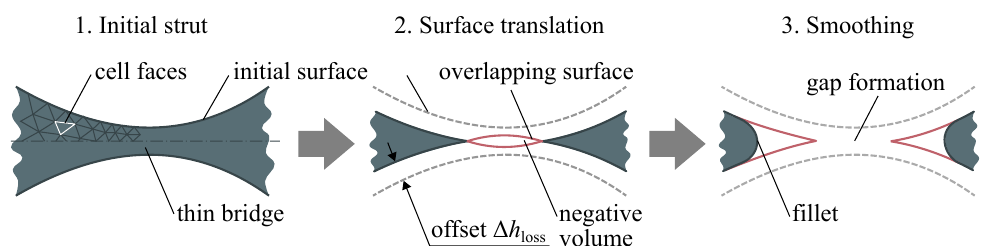
Figure 5. Illustration of the surface translation algorithm nearby the thin